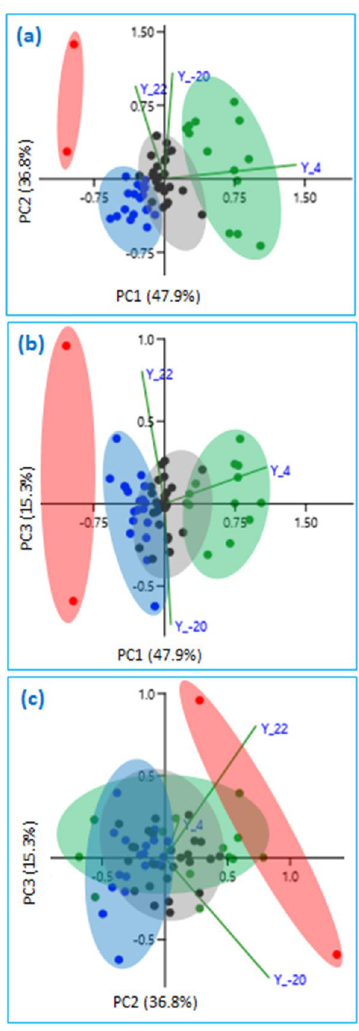
Figure 7. SVOCs groupings by principal components analysis resulting from concentration variance under conditions Y . Vectors include recoveries at − 22 °C (Y_ − 20), 4 °C (Y_4) and 22 °C (Y_22). The first three PCA axes are shown; each plot displays a different combination of axes: ( a ) axes 1 and 2, ( b ) axes 1 and 3, ( c ) axes 2 and 3. Approximate area coverage of the four groupings identified by CA (Fig. 6) are similarly